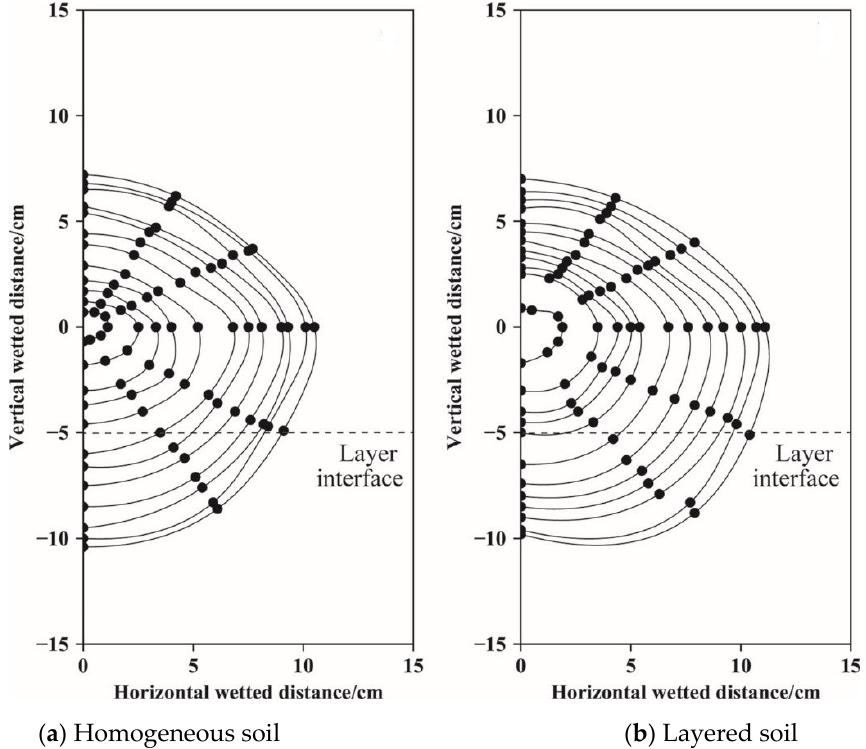
Figure 6. Variations in wetted body with time. The boundary line of the wet body corresponds to 1, 5, 20, 40, 60, 120, 180, 240, 300, 360, 420, and 480 min from the inside to the outside.